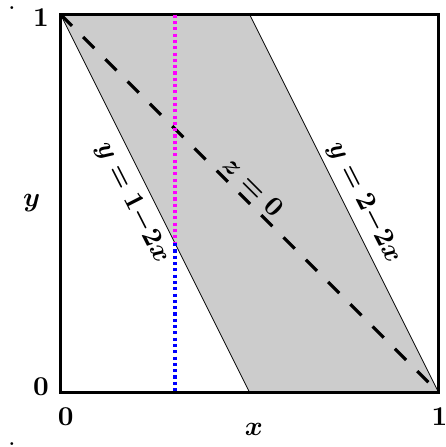
Figure 18 . The shading shows, for each value of x , the maximally-sized interval of y integration that is symmetric under ( x, z ) → ( x, − z ) , which translates to y → 2(1 − x ) − y . The vertical dotted line is an example of the y points for a particular value of x and serves as a visual aid for the fact that, within the shaded region, the y range with z < 0 has the same size as the y range with z > 0 . variables for y to z = 1 − x − y in (3.6a) to get an integral of the